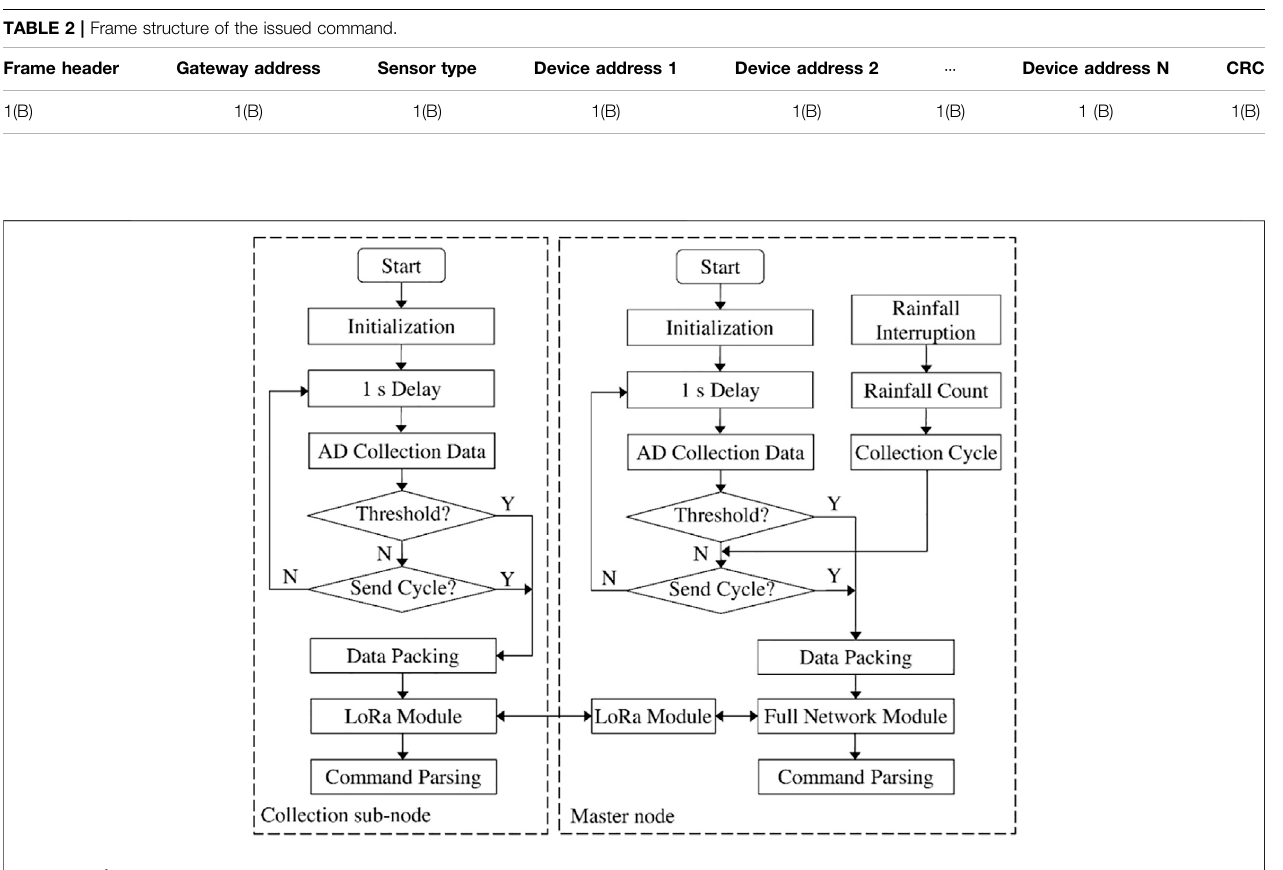
FIGURE 9 | Flow chart of the master node and collection sub-node ad hoc network.